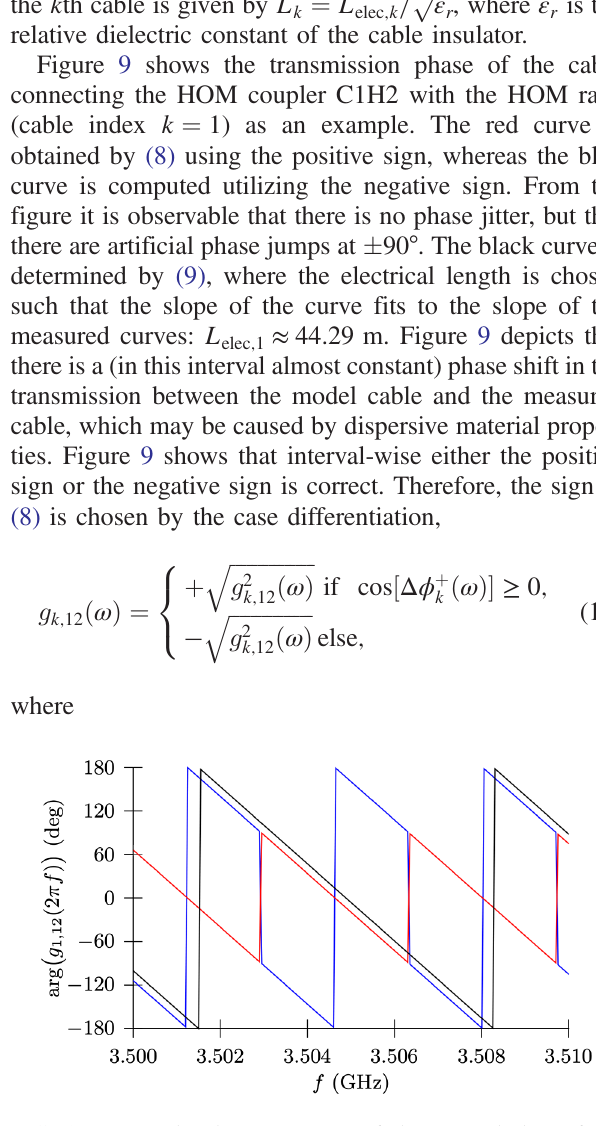
FIG. 8. Network equivalent of the conducted measurement of cable reflections. The block on the left-hand side depicts the termination resistance with the reflection factors Γ ¼ f 0 ; 1 ; − 1 g . a 1 denotes the incident and b 1 the scattered wave amplitude at the termination resistance. The block on the right side shows the cable with its respective amplitudes of incident and scattered ; and d waves ( c , where l denotes the port index). The l l connection between the cables and the termination resistance is expressed by the dashed lines. Although not indicated in the drawing, all wave amplitudes are frequency-dependent (and complex-valued) quantities.